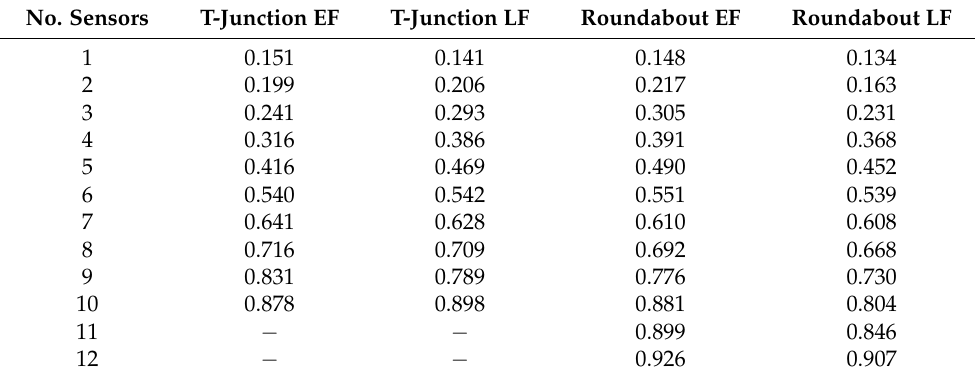
Table 6. Comparative performance analysis considering the F-PointNet model and various numbers of the active